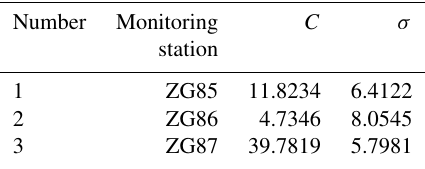
Table 2. Optimal parameters of the LSSVM model. Number Monitoring C σ